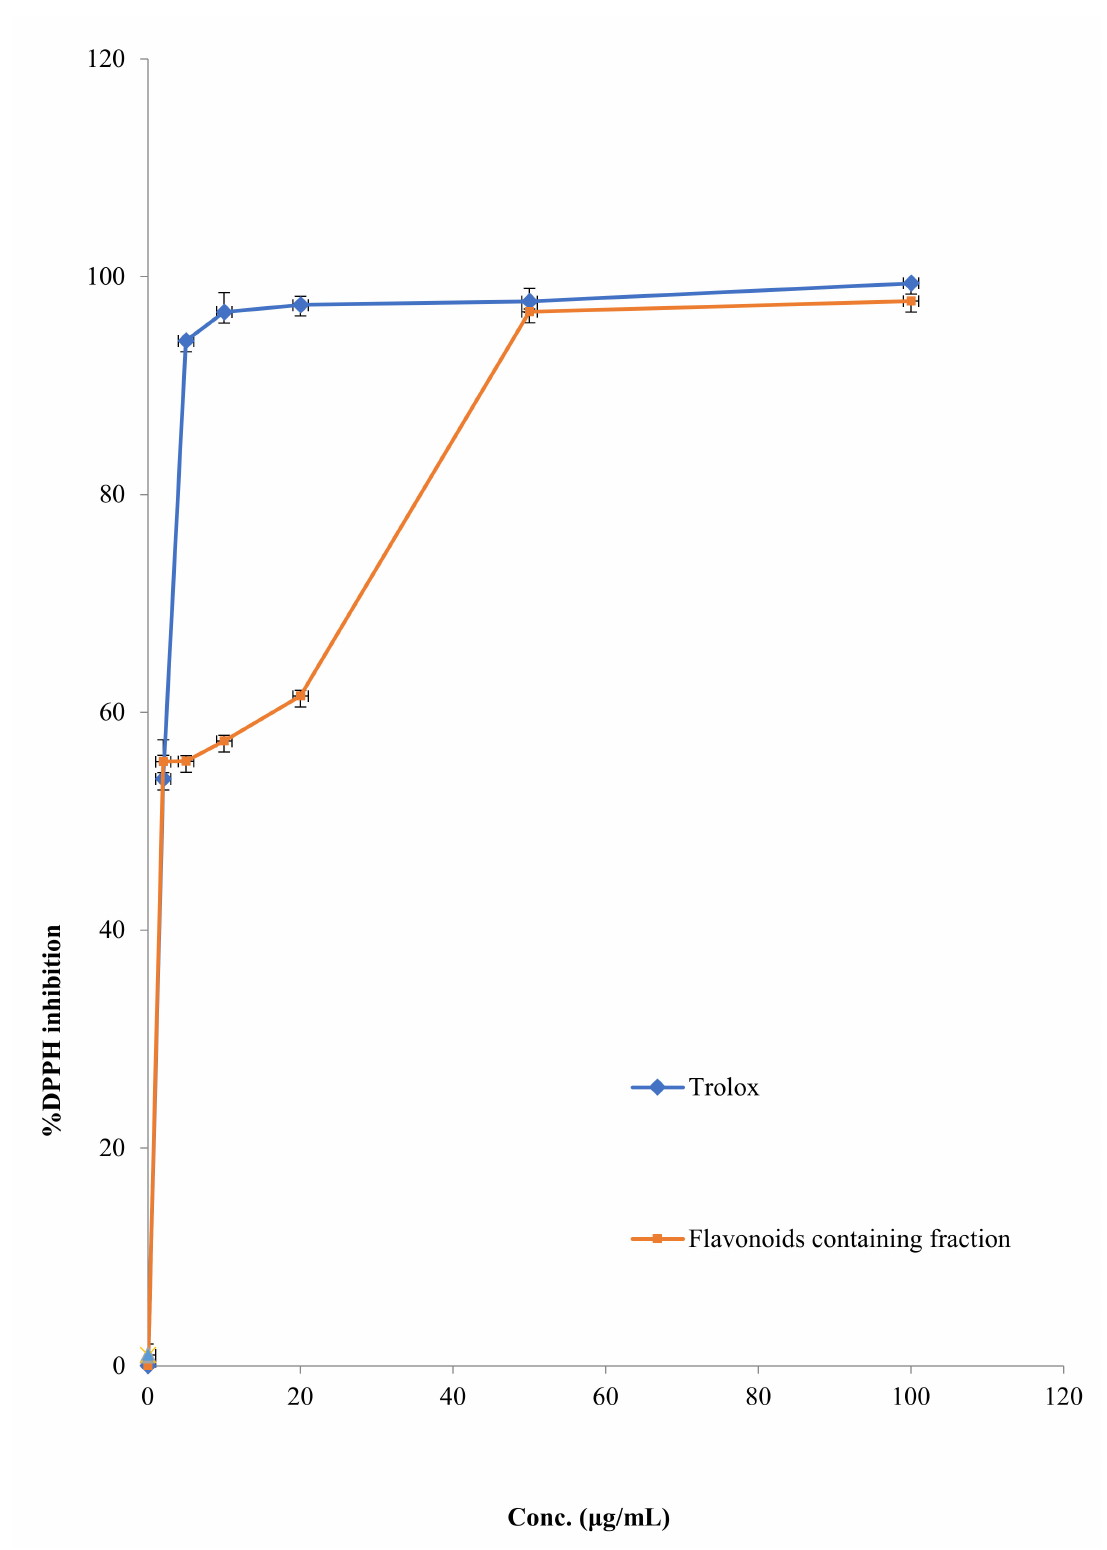
Figure 6. DPPH inhibitory potentials by FFM and